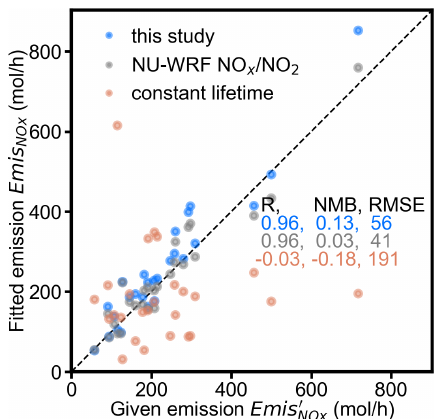
Figure 7. Scatterplot of the fitted total NO x emissions Emis NO x as compared to the given total emissions Emis (cid:48) under different NO x scenarios. The blue, grey, and red dots represent the scenarios based on the fitted lifetime τ and a constant NO x to NO 2 ratio of 1.32 (“this study”), the fitted lifetime τ and the NO x to NO 2 ratio given by the NU-WRF model (“NU-WRF NO x / NO 2 ”), and a constant lifetime of 2.5h and a constant NO x to NO 2 ratio of 1.32 (“constant lifetime”), respectively. The dashed line represents the 1 : 1 line. Statistics are provided in the inset